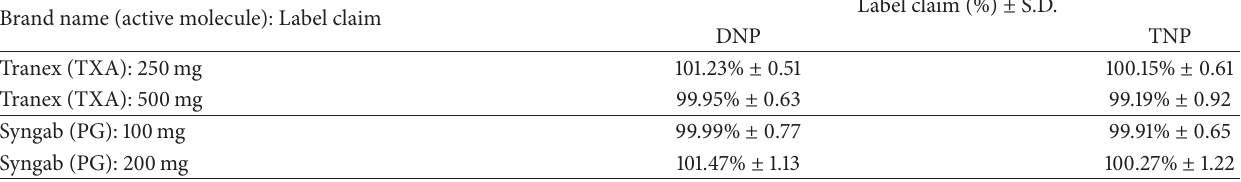
Table 4: Recovery studies in commercial